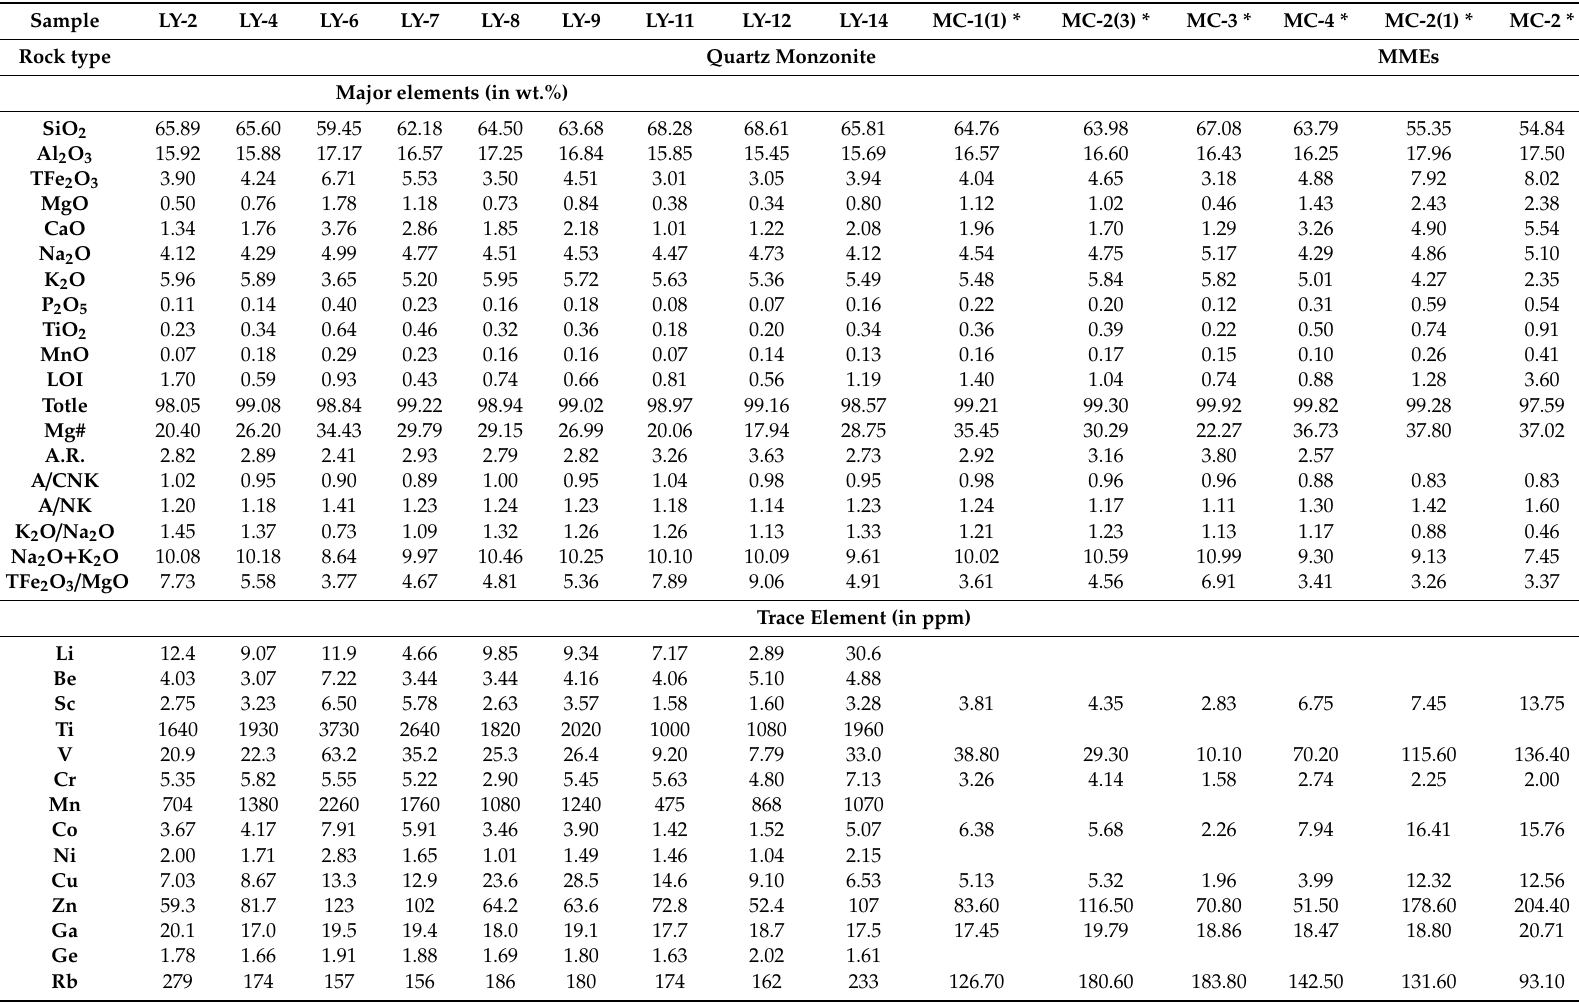
Table 1. Chemical Composition of Muchen